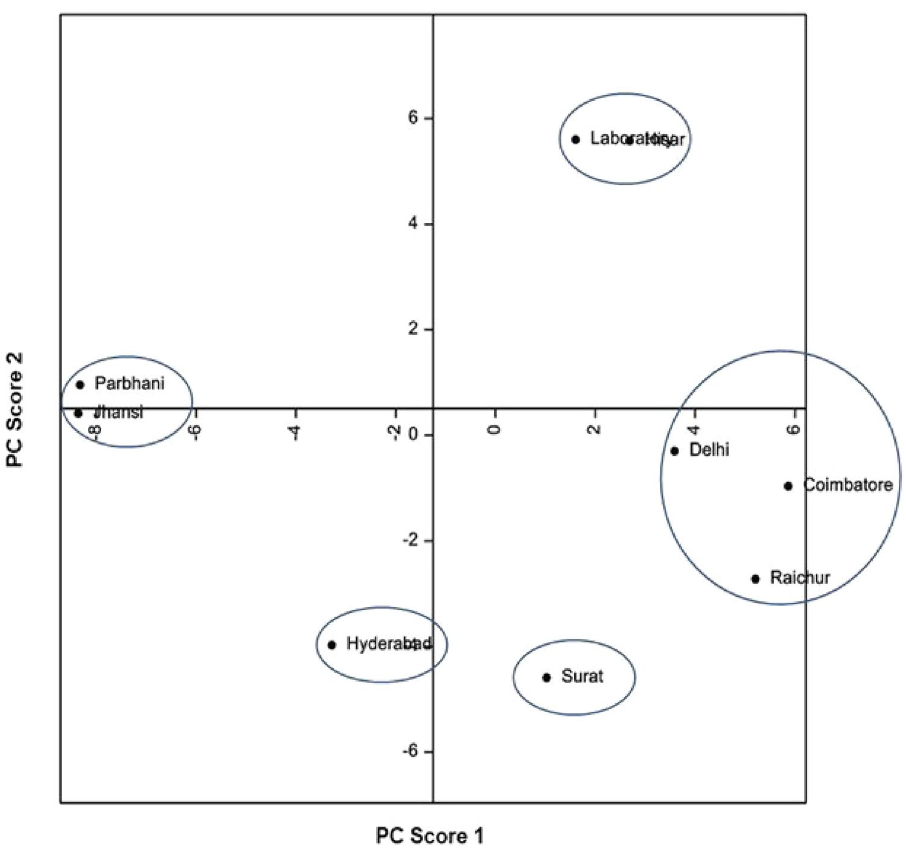
Figure 2. Diversity in different geographical C. partellus populations based on lipophilic